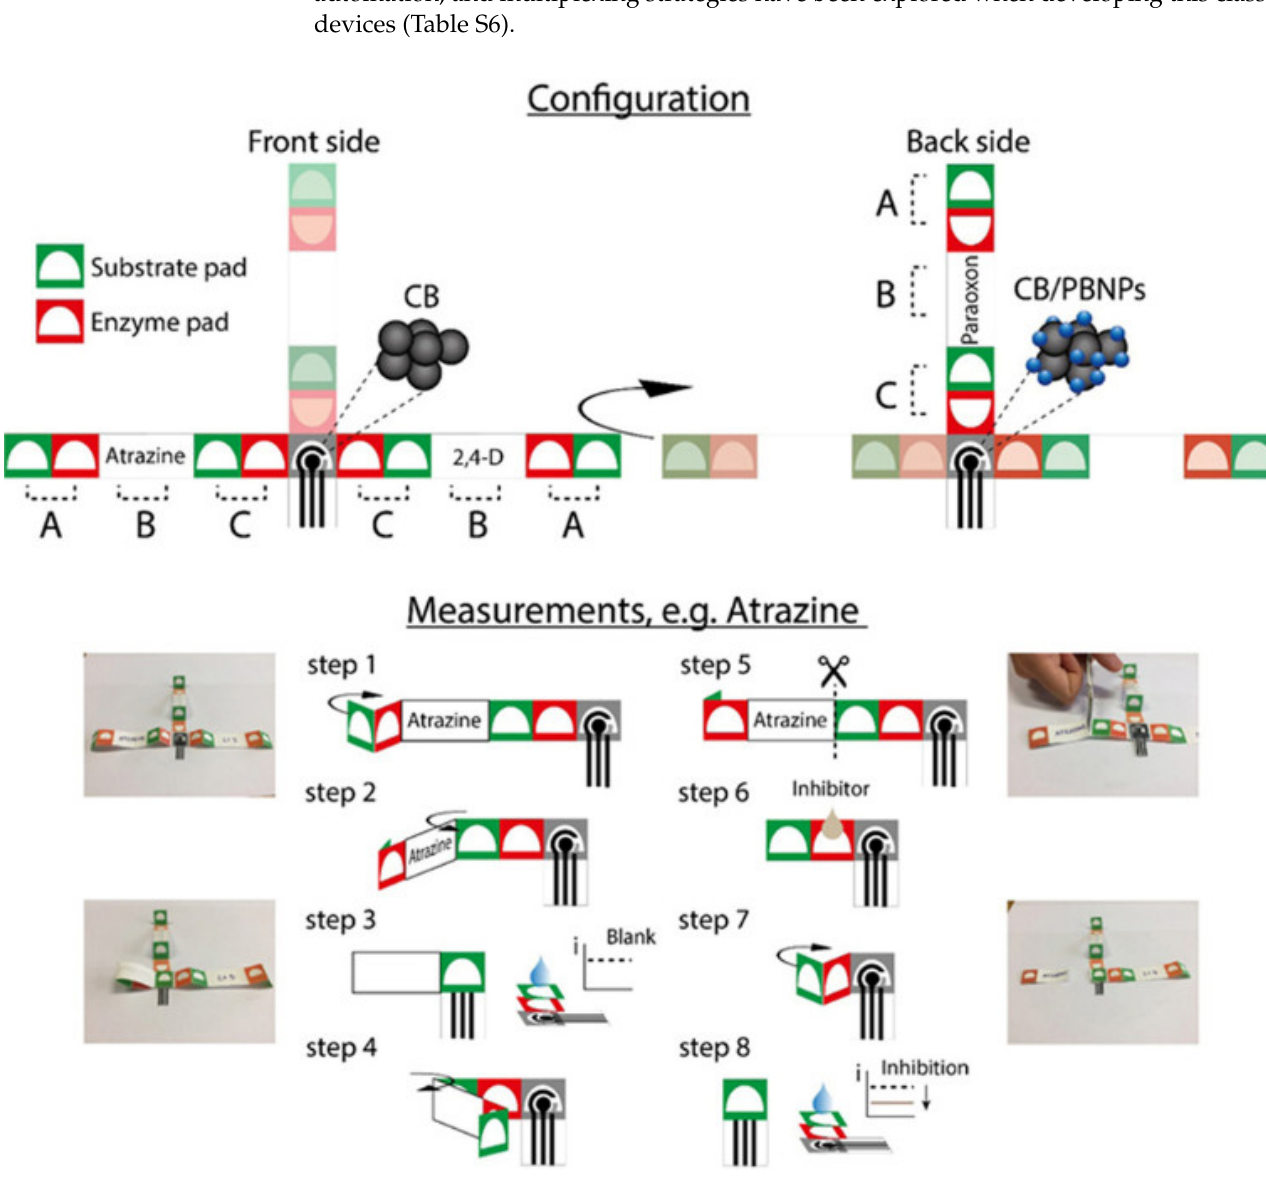
Figure 5. An example of a paper-based electrochemical food analyzer. The three-dimensional origami paper-based device was used for the detection of several classes of pesticides in river water based on the enzyme-inhibition assay. The multiplex analysis was achieved by folding and unfolding different parts of the paper-based origami structure. The measurement was performed with no need for adding reagents or sample preparation. Reproduced from [94] Biosensors and Bioelectronics, Copyright (2019), with permission from Elsevier.